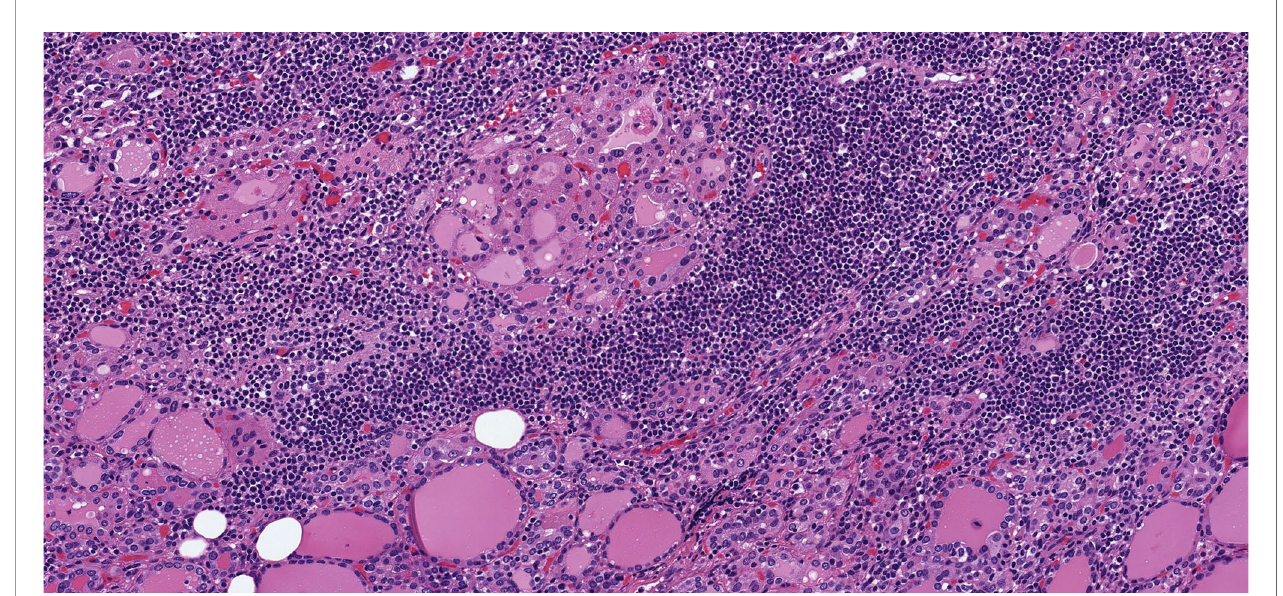
FIGURE 1 | Oncocytic Change in Chronic Lymphocytic Thyroiditis. Chronic lymphocytic thyroiditis is characaterized by a diffuse lymphoplasmacytic in fi ltrate that forms lymphoid follicles with germinal centers and is associated with oncocytic change of follicular epithelial cells that develop large, granular eosinophilic